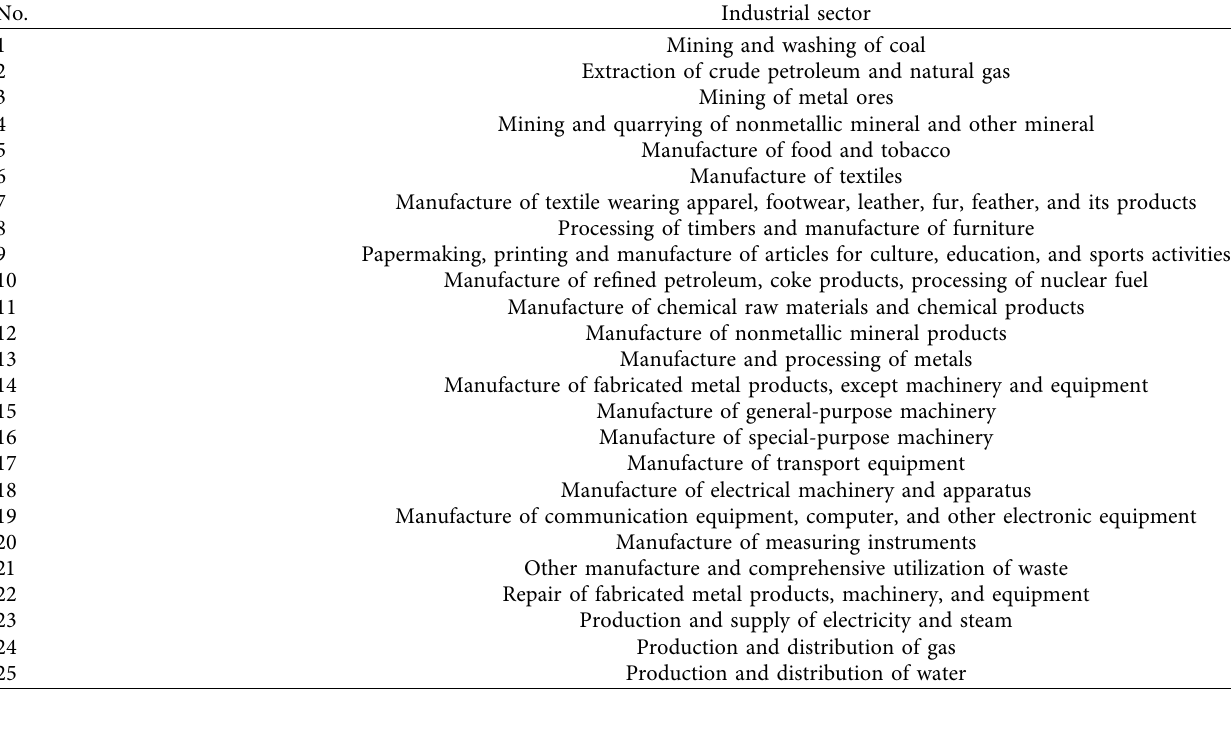
Table 2: Industrial sector classifcation and number.